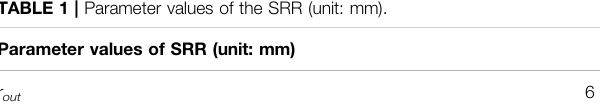
TABLE 1 | Parameter values of the SRR (unit: mm). Parameter values of SRR (unit: mm)